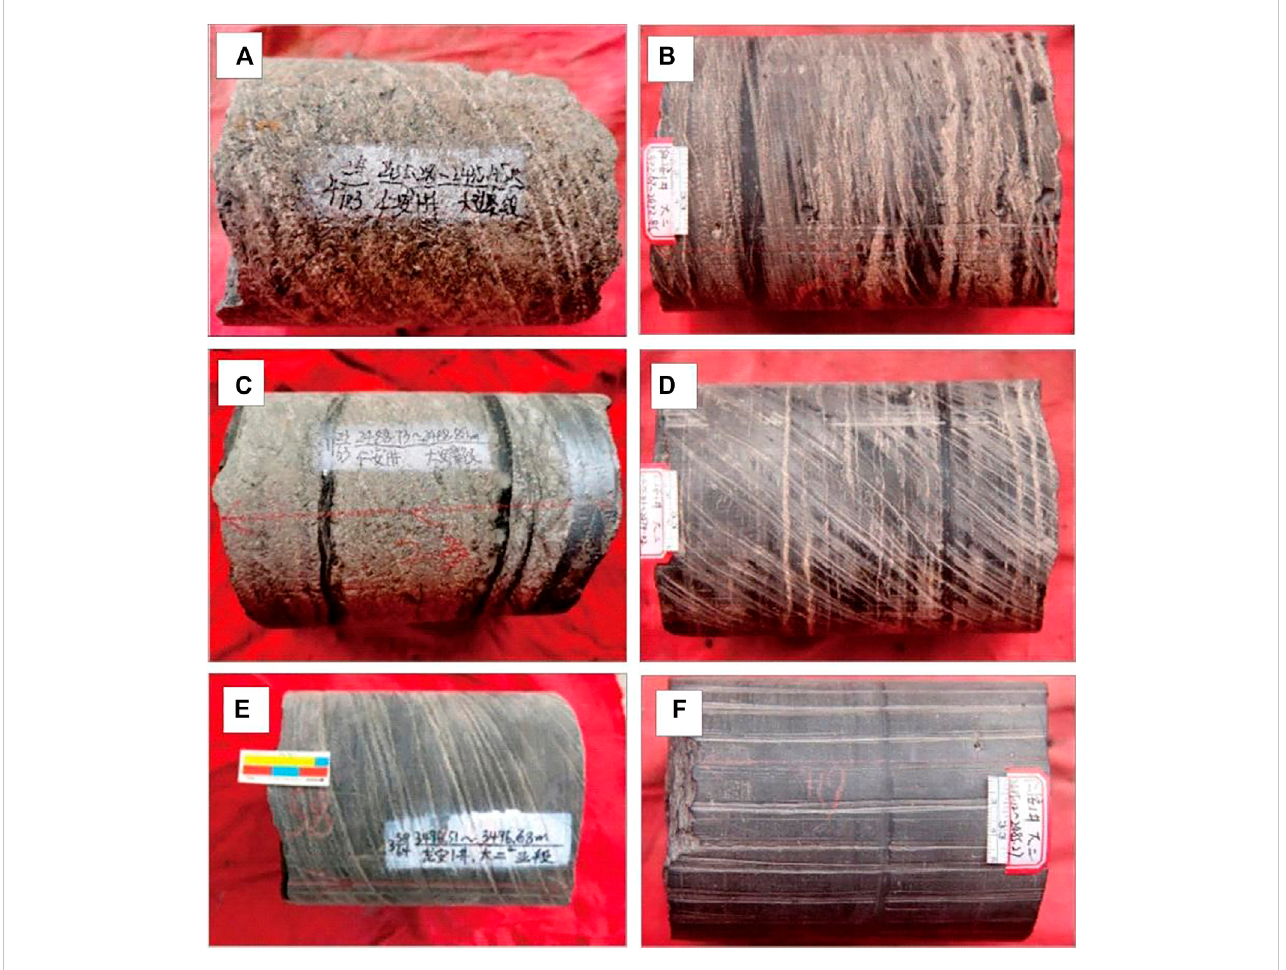
Photographs of cores showing the developmental characteristics of different lithofacies in Well RA1; (A) massive mud-bearing shell limestone, Lithofacies F, 2,435.28 – 2,435.45 m; (B) laminated shell-bearing shale, Lithofacies B, 2,466.94 – 2,466.97 m; (C) thin shell calcareous shale, Lithofacies